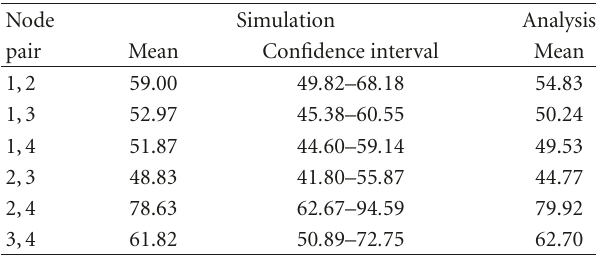
Table 4: Statistics of the node intermeeting